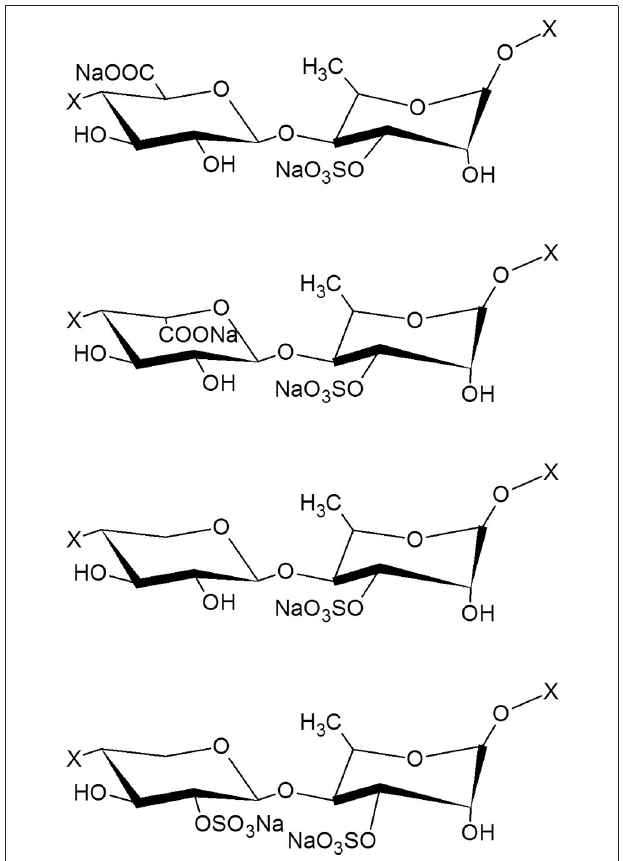
FIGURE 1 | Structure of the main disaccharide motifs present in ulvan. From the top to the bottom: β (1,4)-D-GlcA- α (1,4)-L-Rha 3 sulfate, β (1,4)-L-idoA- α (1,4)-L-Rha 3 sulfate, β (1,4)-D-xyl- α (1,4)-L-Rha 3 sulfate, β (1,4)-D-xyl 2-sulfate- α (1,4)-L-Rha 3 sulfate, where X represents the continuation of the polysaccharide chain. GlcA, glucuronic acid; Rha, rhamnose; IdoA, iduronic acid; Xyl,